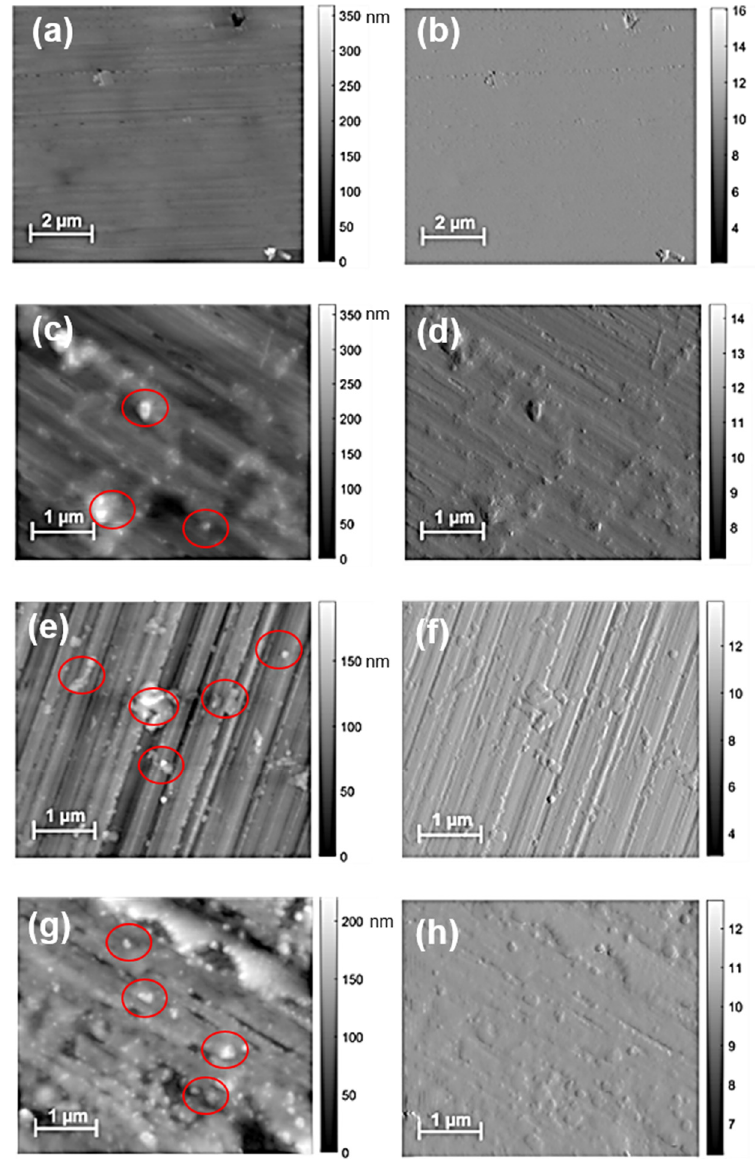
Figure 3. AFM topography and amplitude images of the pure polymer sample ( a , b ), MDPs–red resin composite with 1 wt% MDPs ( c , d ), MDPs–green resin composite with 1 wt% MDPs ( e , f ), and MDPs–amber resin with 0.5 wt% MDPs ( g , h )